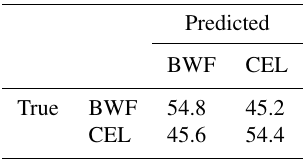
Table 4. Confusion matrix of two substances that have very similar